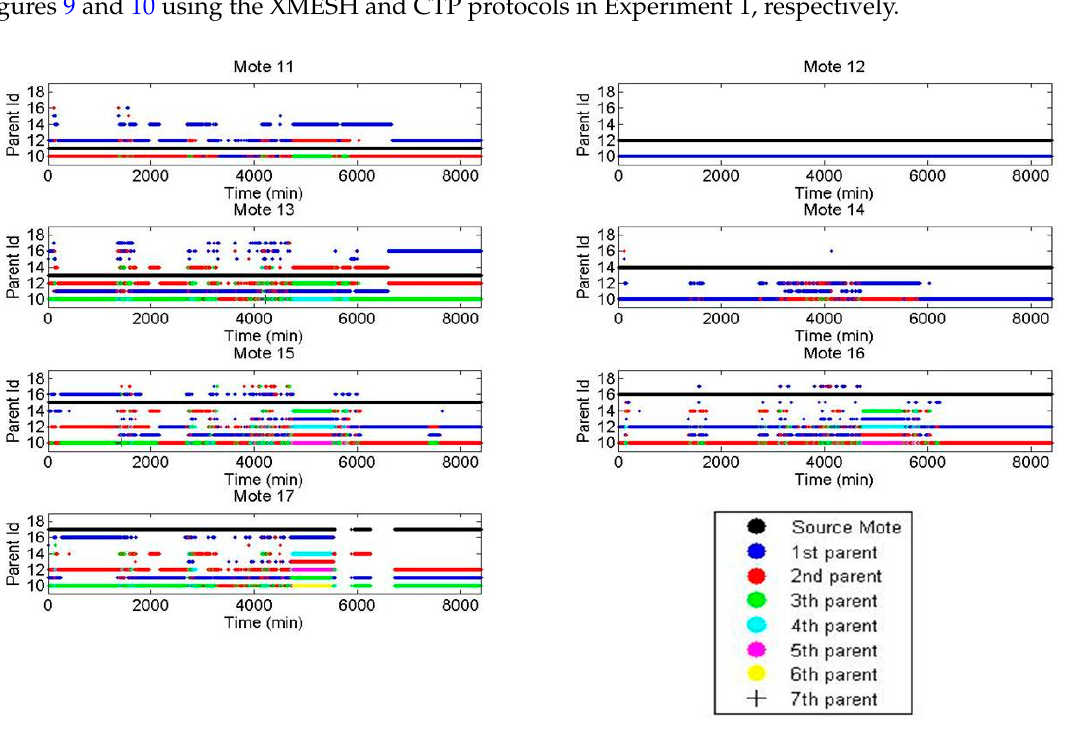
Figure 9. Route distribution for each mote using the XMESH protocol in Experiment 1.